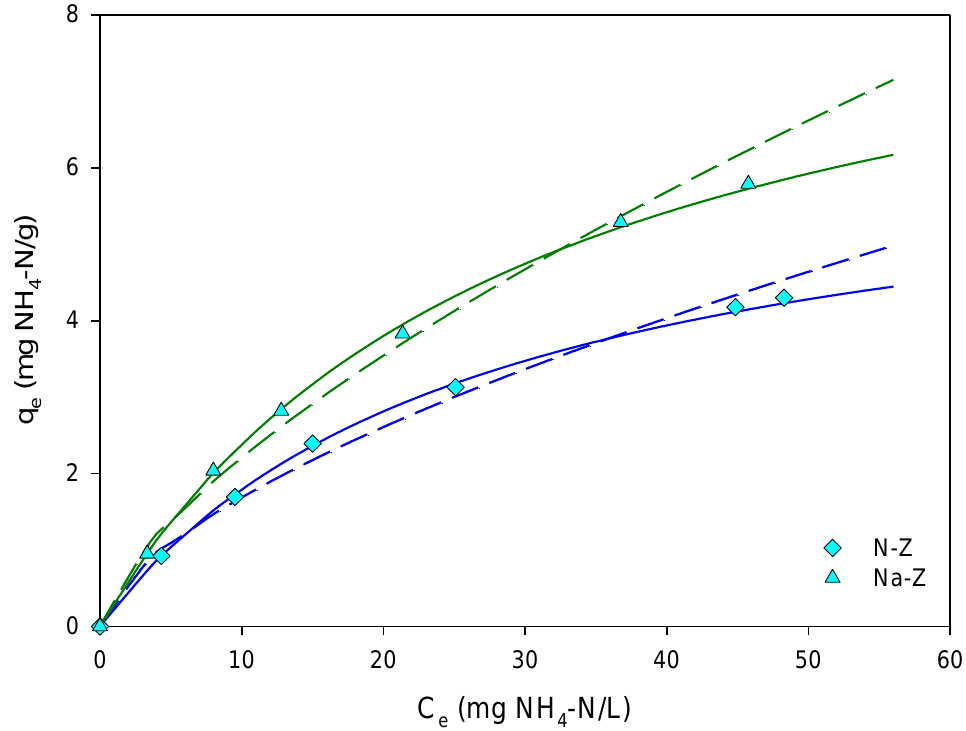
Figure 4. Comparison of the isotherms carried out with the natural zeolite (N-Z) and the zeolite activated by NaOH (Na-Z) together with the adjustment of both experimental data by the Langmuir (continuous line) and Freundlich (dashed line) models.